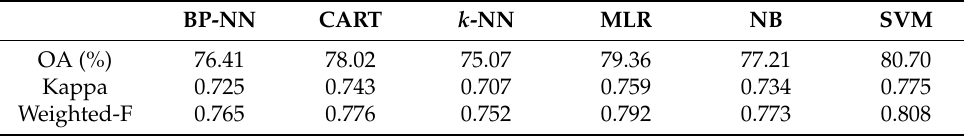
Table 3. Overall accuracies, kappa values, and weighted-average F-scores of the six